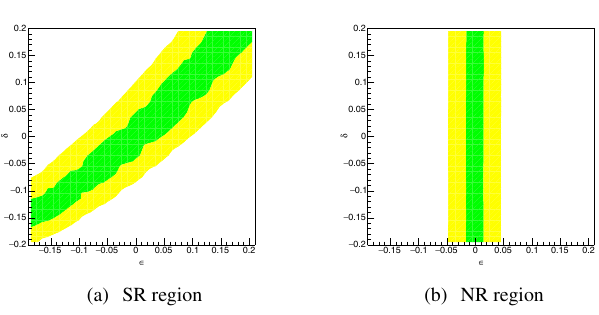
Figure 1. Constraints on the (cid:31) and δ parameters from the t-channel CS for the 14 TeV collision energy measured with 5% uncertainty. Green and yellow arias correspond to exclusion limits at 68% and 95%